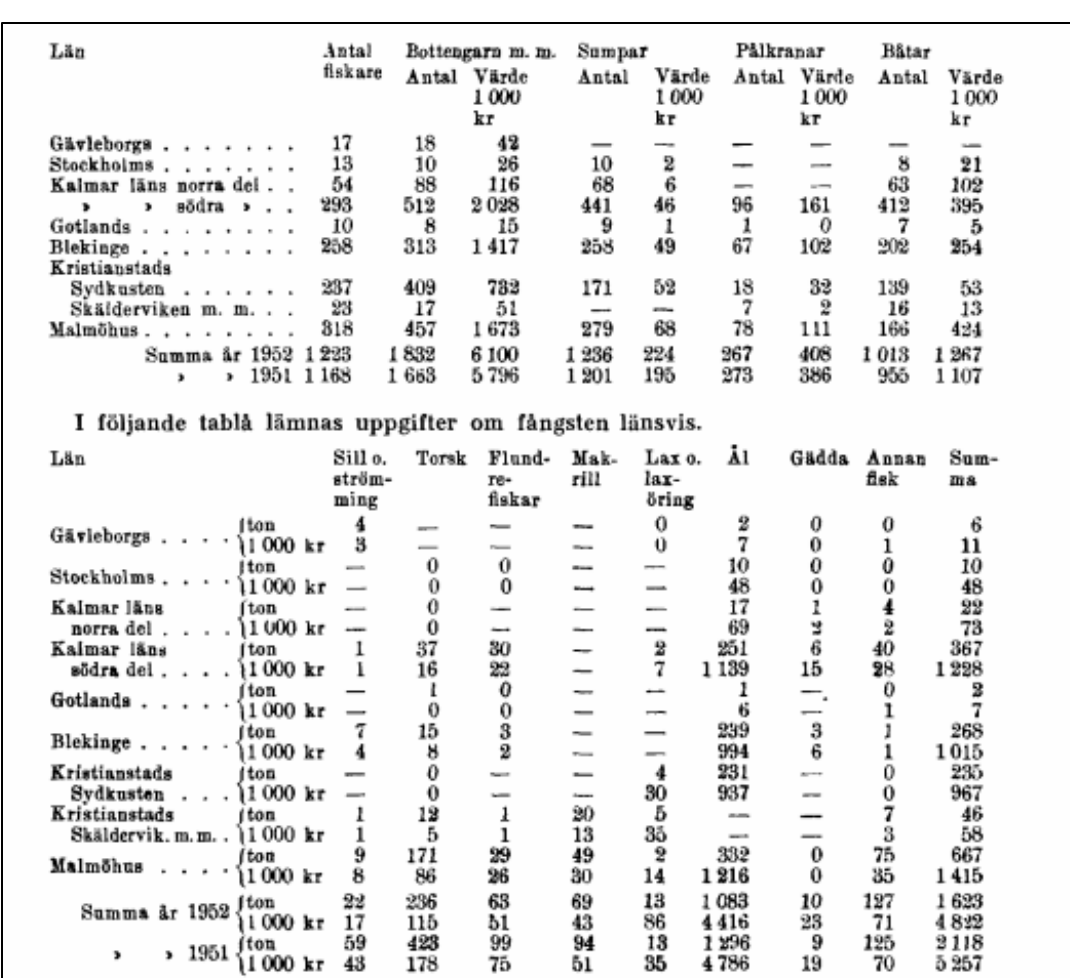
Figure A1.1. Presentation of the pound net fishery in the statistical year books. This example refers to